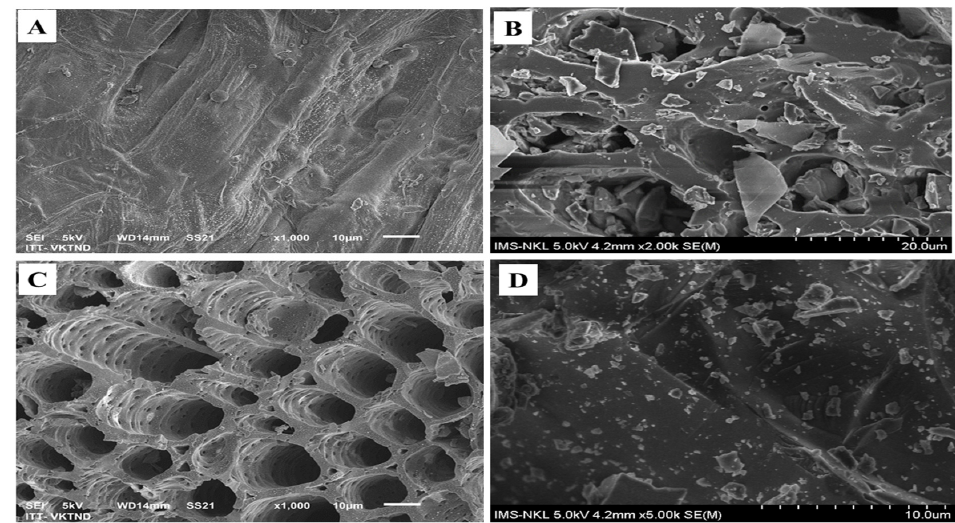
Figure 2. SEM images of CC ( A ), CB400 ( B ), CB600 ( C ), and apatite ore ( D ).